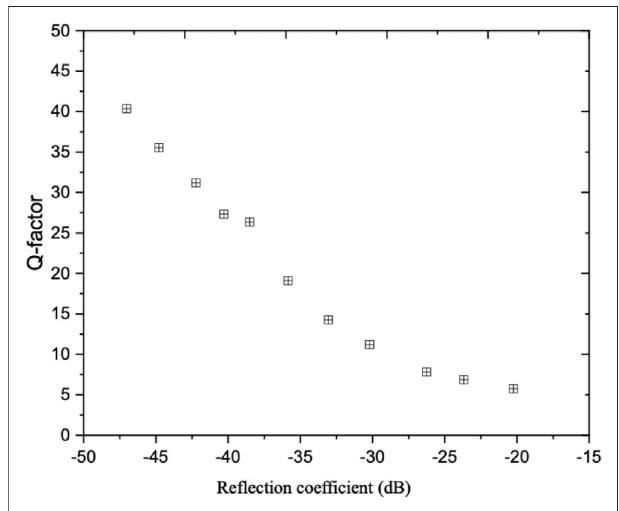
FIGURE9| Paretofrontofthere fl ectioncoef fi